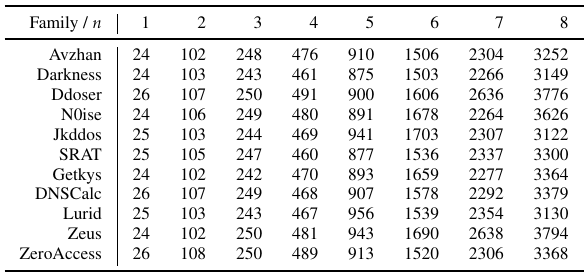
Table 3. The number of unique n -grams actually observed in each of the studied families for varying values of n